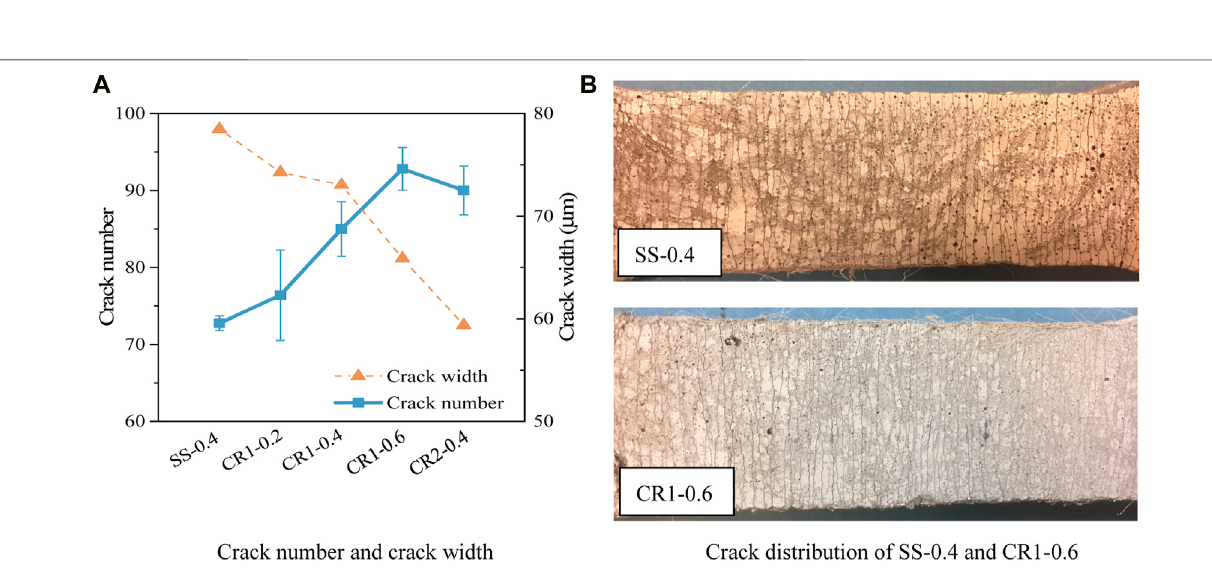
Frontiers in Materials |